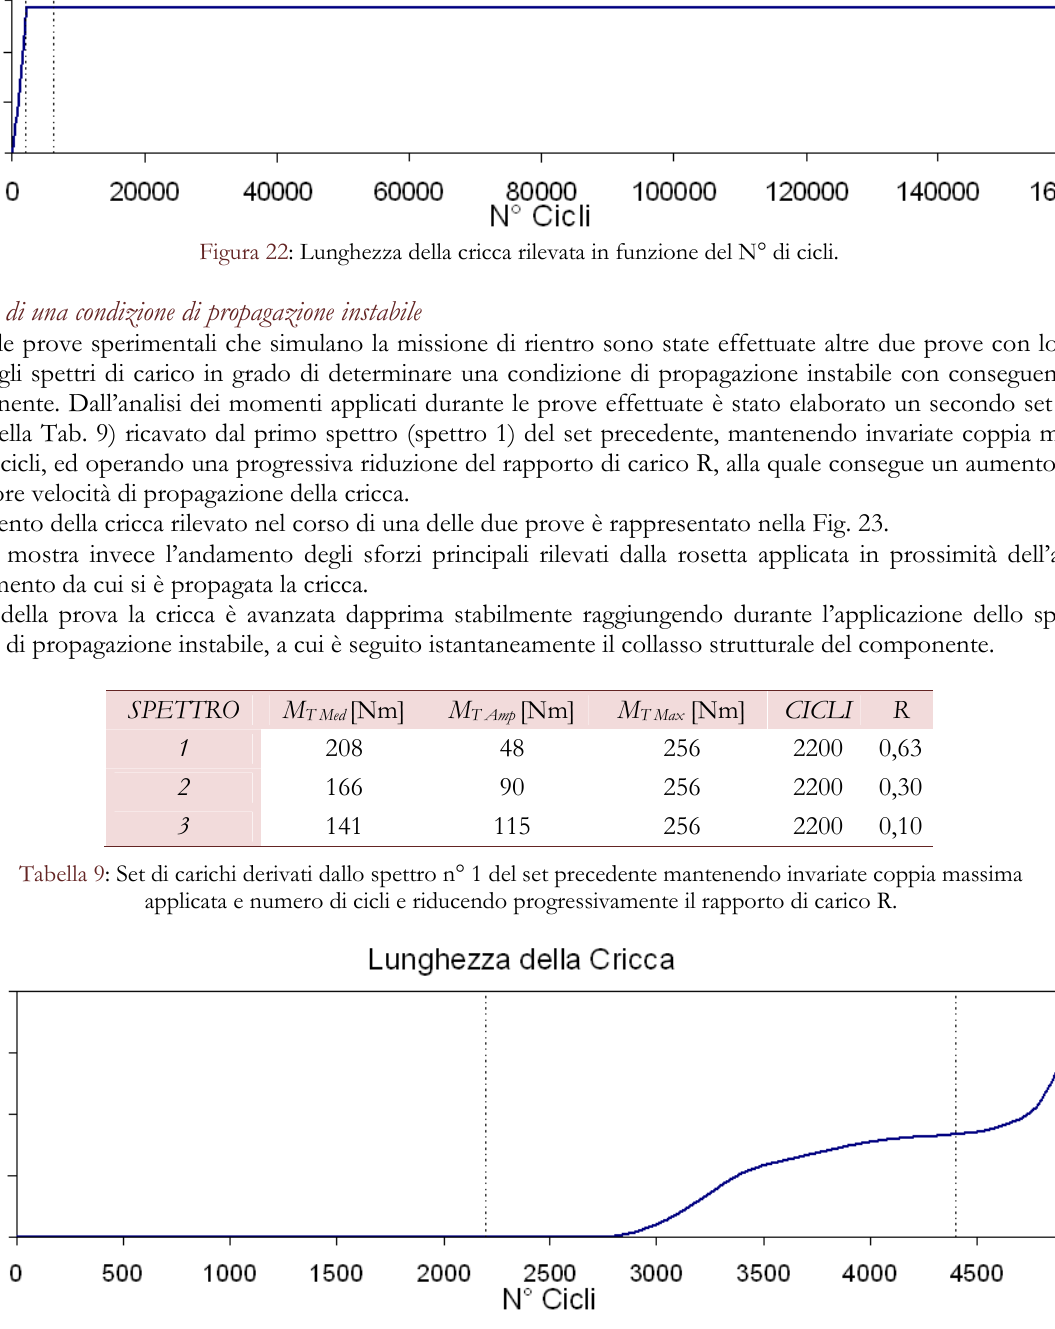
Figura 23: Lunghezza della cricca rilevata nel primo test in funzione del n° di cicli: la velocità di propagazione aumenta improvvisamente nel corso del 3°spettro cui corrisponde il minimo rapporto